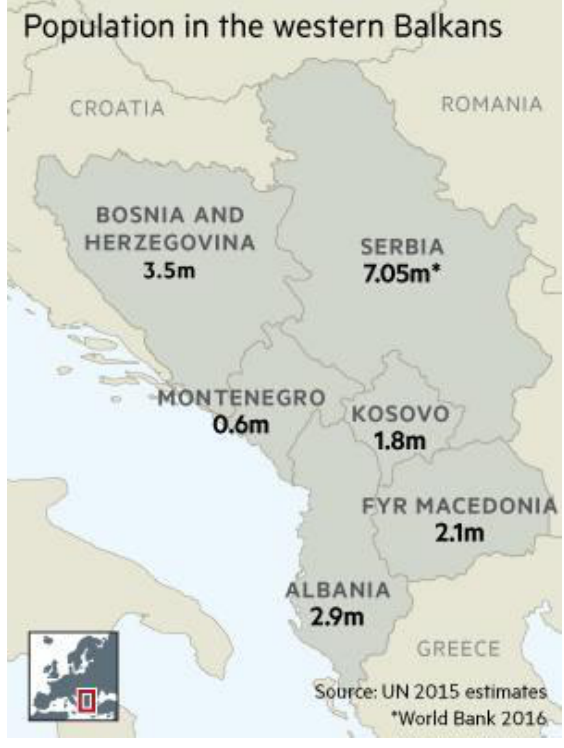
Figure 3. Map of the Western